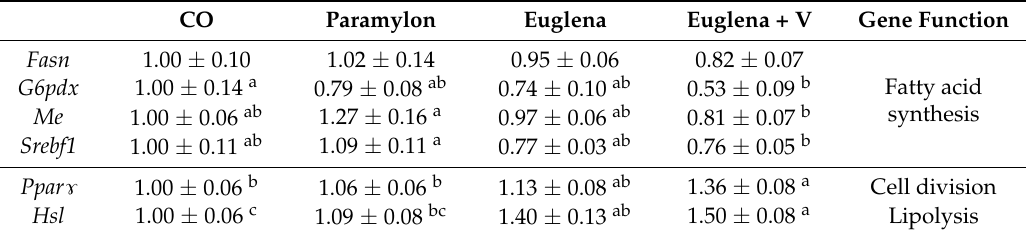
Figure 4. Effects of intake of Euglena and vegetables on white adipose tissue in mice. ( a ) Epididymal adipose tissue sections from representative mice in each group (hematoxylin & eosin, scale bar = 100 µ m). ( b ) Adipocyte size ratio values are presented as the mean ± standard error of the mean, n = 10. Different superscript letters indicate significantly different means at p < 0.05 (refer to “Result” in detail). CO, control diet group; Paramylon, the group that received the normal diet containing 0.3% paramylon; Euglena, the group that received the normal diet containing 1.0% Euglena; Euglena + V, the group that received the normal diet containing 1.0% Euglena and 0.3% vegetables. Table 6. mRNA expression level in white adipose tissue